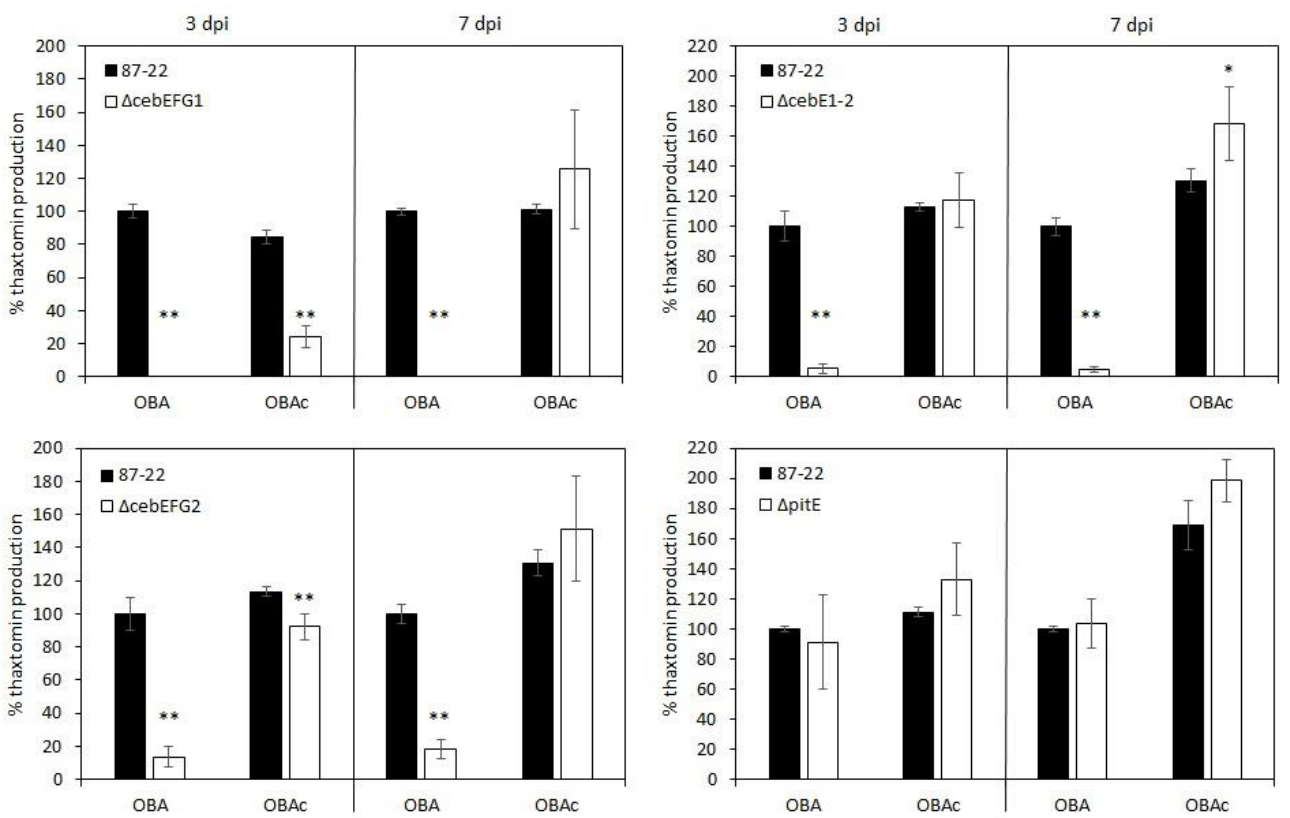
Figure 6. Thaxtomin production levels of the mutant strains compared to the wild type (87-22) on a plant-based medium without (OBA) and with (OBAc) the addition of cellobiose. Thaxtomin was extracted from agar plates at 3 and 7 dpi and analyzed by HPLC. Thaxtomin levels produced by the wild type were set as 100%. For the mutant strains, the means (± standard deviation) of at least three independently generated mutant isolates plated in duplicate are shown. Mutants that produced statistically different thaxtomin levels compared to the wild type grown under the same conditions are indicated by * if p < 0.05 and ** if p < 0.025.